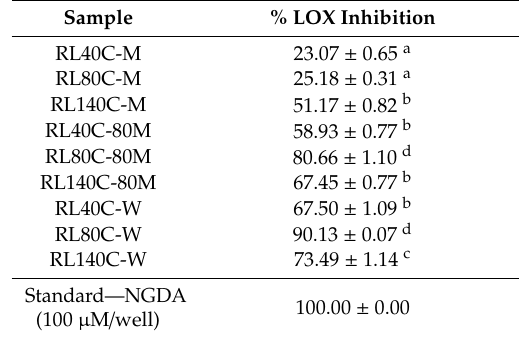
Table 4. Inhibition of lipoxygenase (LOX) by R. luteum samples tested at the concentrations of 50 µ g of dry extract / mL of the reaction mixture. The results are given in % of enzyme inhibition. Abbreviations: NGDA—nordihydroguaiaretic acid; other abbreviations as in Table 1.